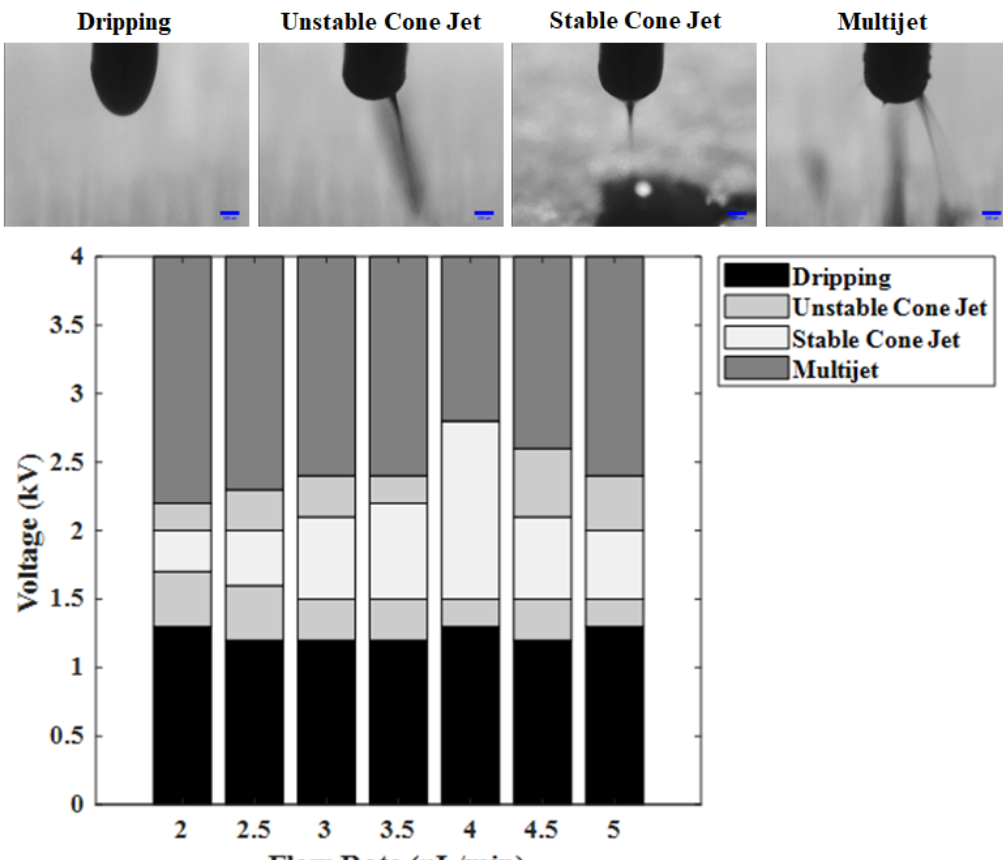
Figure 7. Meniscus stability diagram with flow rate–voltage condition and meniscus shape.